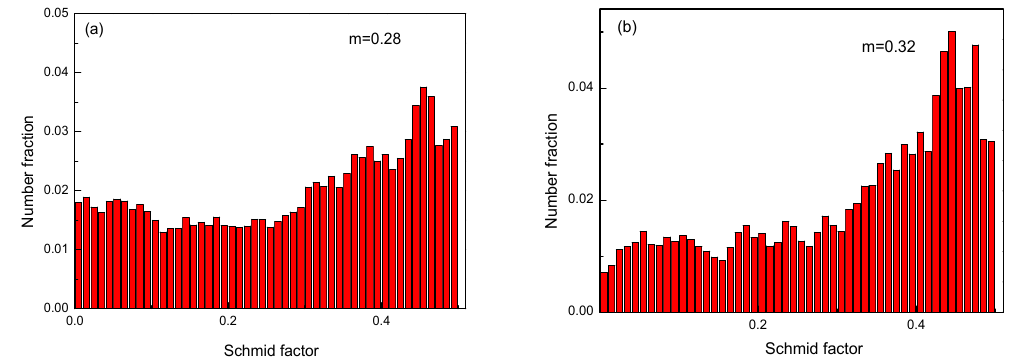
7 of 11 Figure 8. Electron backscattered diffraction (EBSD) analysis results: pole figures of the as-rolled state ( a ) and extruded state ( b ). Consequently, to assess the effect of texture on strength, the Schmid factors were determined in terms of basal slip. Figure 9 shows the Schmid factor maps of the Mg-2Y-0.6Nd-0.6Zr alloy samples.